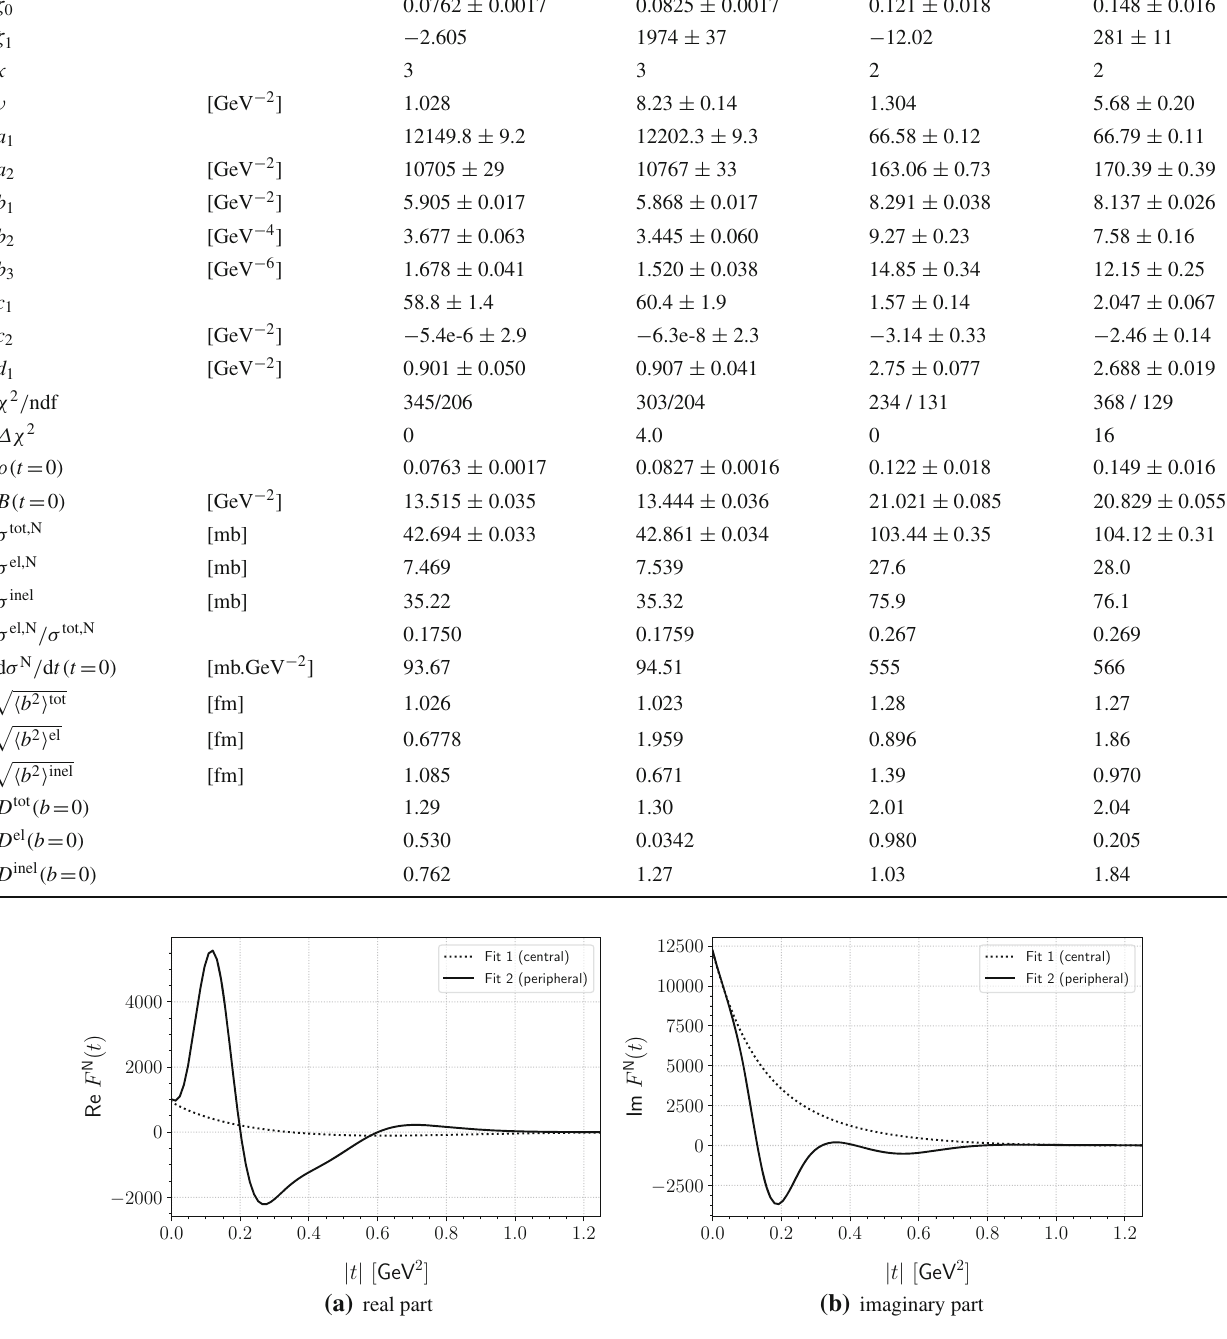
Fig. 4 The real and imaginary parts of elastic hadron scattering amplitude corresponding to Fits 1 and 2 at 52.8